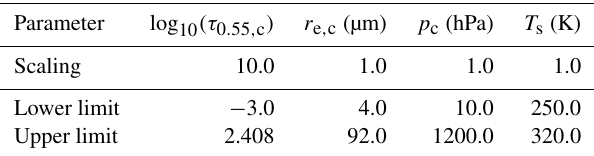
Table 4. Ice cloud scaling parameters and lower and upper retrieval